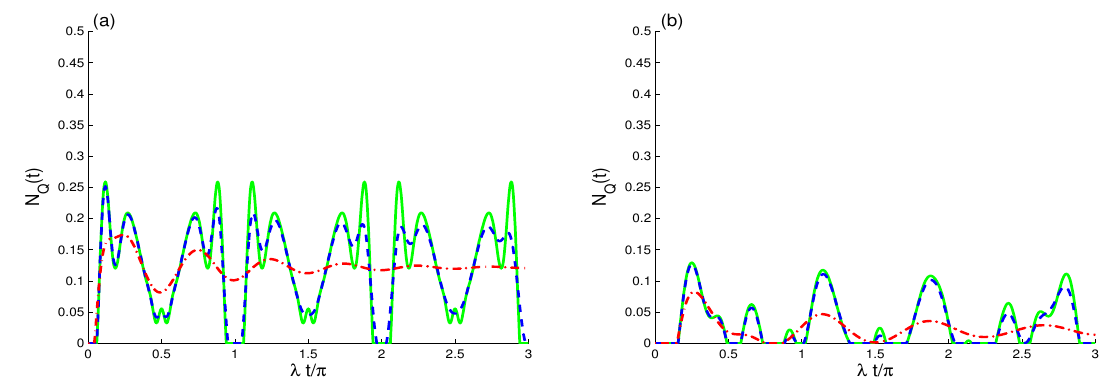
Figure 9. As Figure 8 ( a ) but for different cases: ( k , α ) = ( 1,5 ) in ( a ) and ( k , α ) = ( 1 decoherence values of γ : γ / λ = 0 (green solid curves), γ / λ = 0.001 (blue dashed curves), and γ / λ = 0.03 (red dashed dot